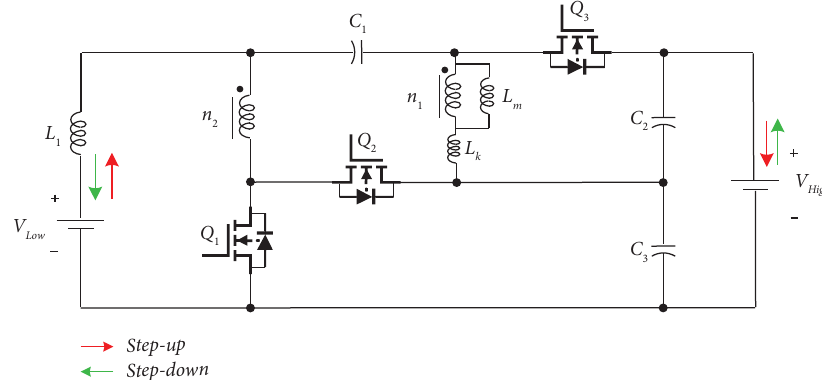
Figure 1: Te power circuit of the suggested